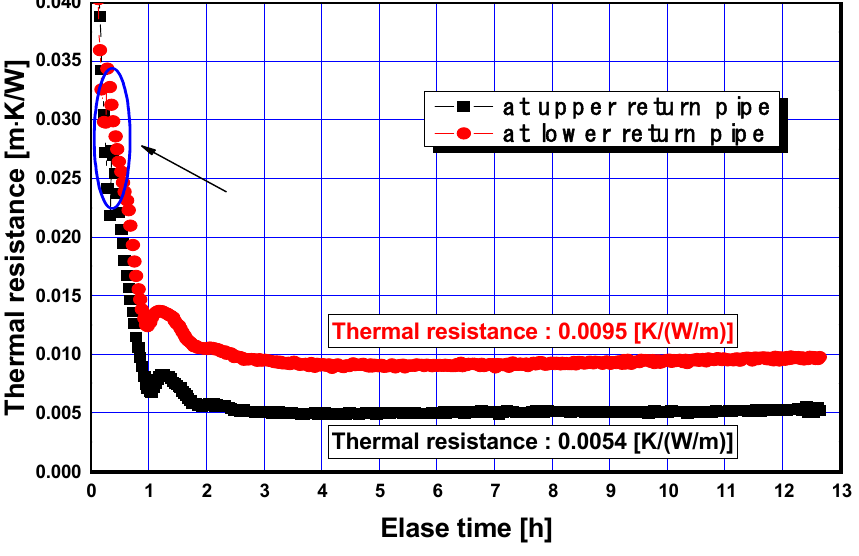
Figure 10. Resistance value at the lower and upper locations of the return pipe.